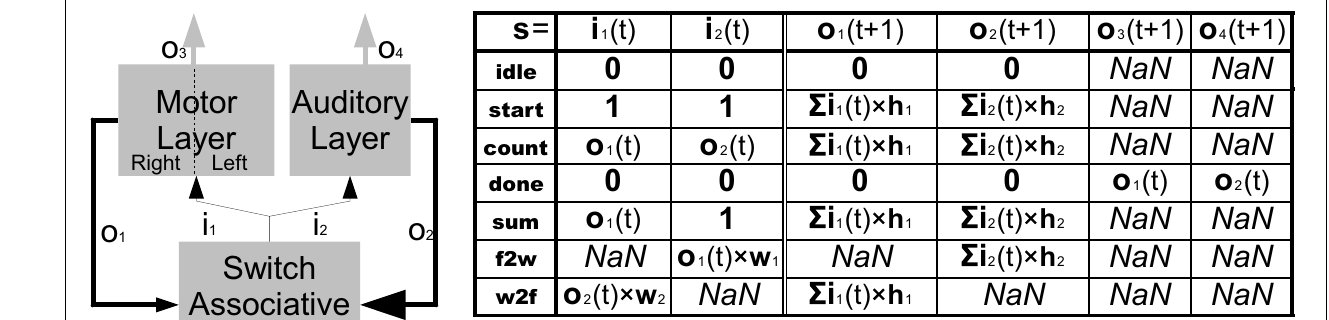
activations of one layer from the ones of the other. Bold lines indicate a full weighted connection, while normal lines are single connections. For simplicity hidden units of the two RNNs of the motor system are represented with one